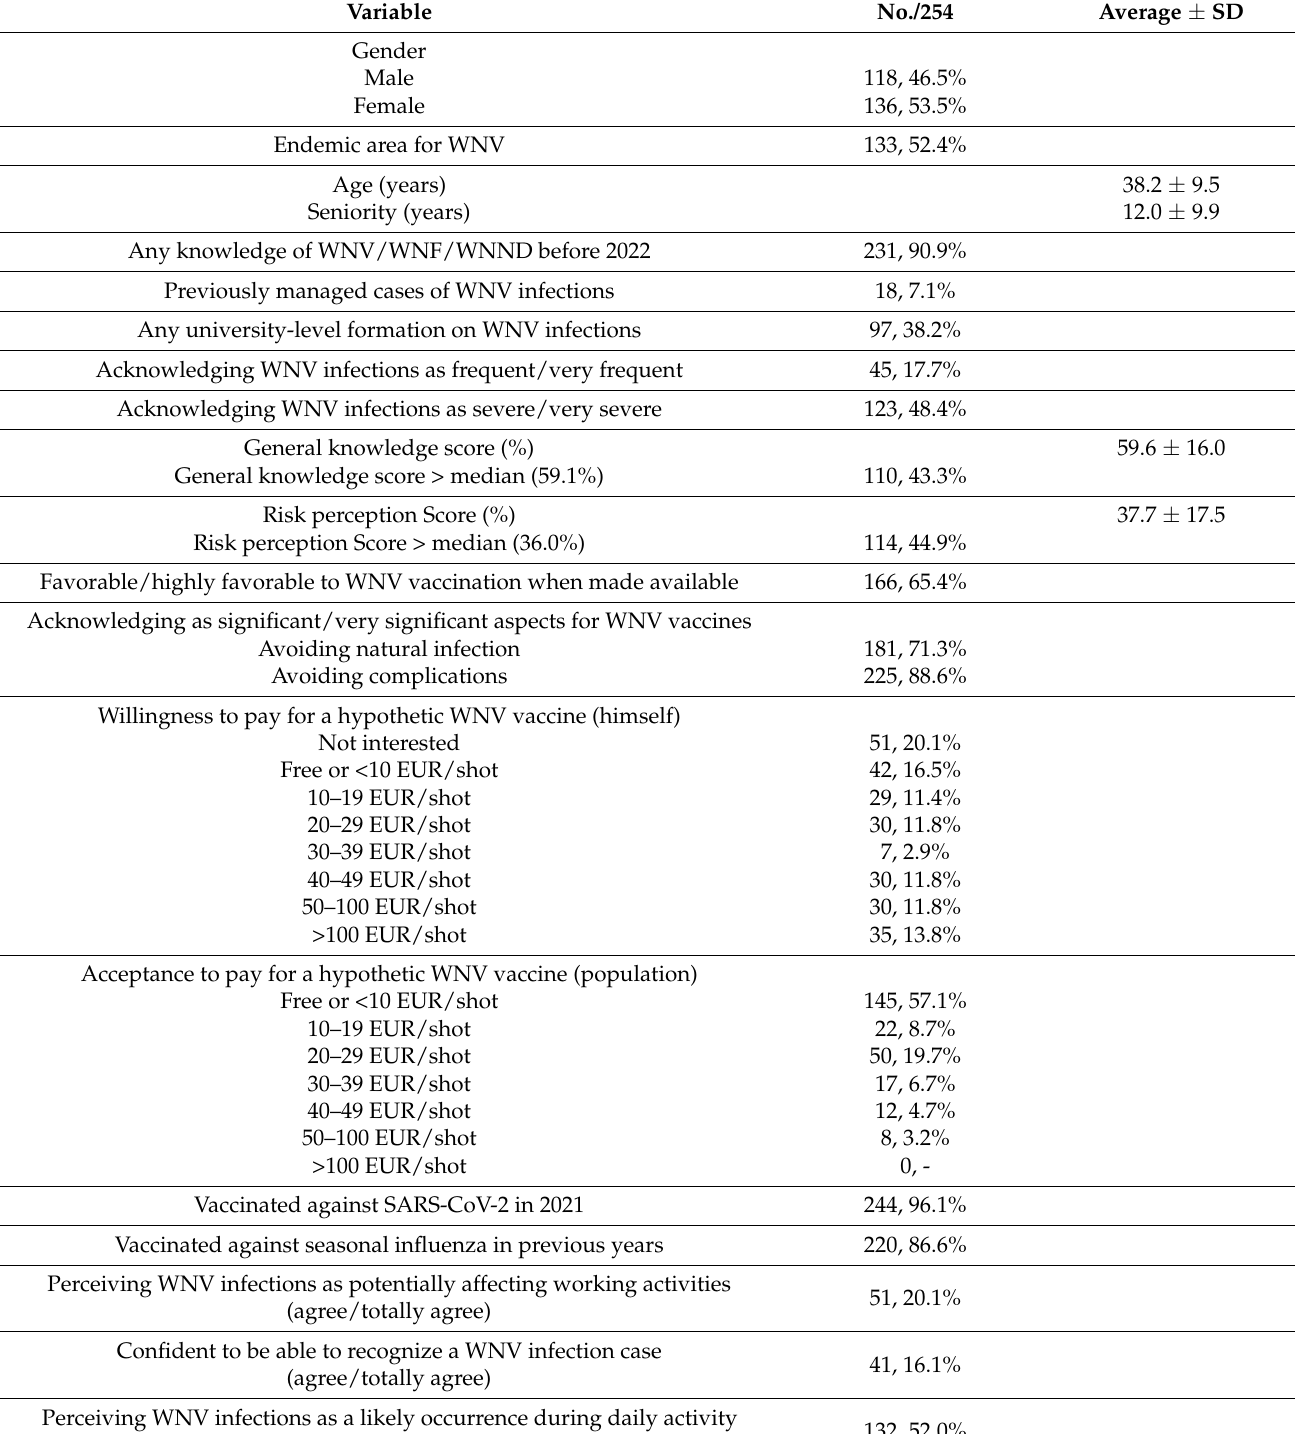
Table 1. Characteristics of the 254 Italian medical professionals participating into the survey on knowledge, attitudes, and practices on West Nile virus (WNV) infections (Italy, Summer 2022). Variable No./254 Average ± SD Gender Male 118, 46.5% Female 136, 53.5% Endemic area for WNV 133, 52.4% Age (years) 38.2 ± 9.5 Seniority (years) 12.0 ± 9.9 231,